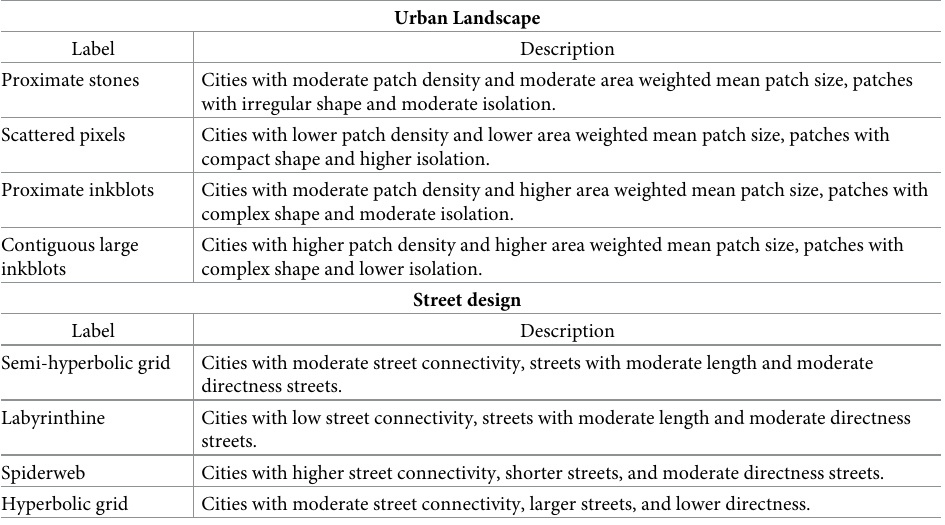
Table 3. Urban landscape and street design